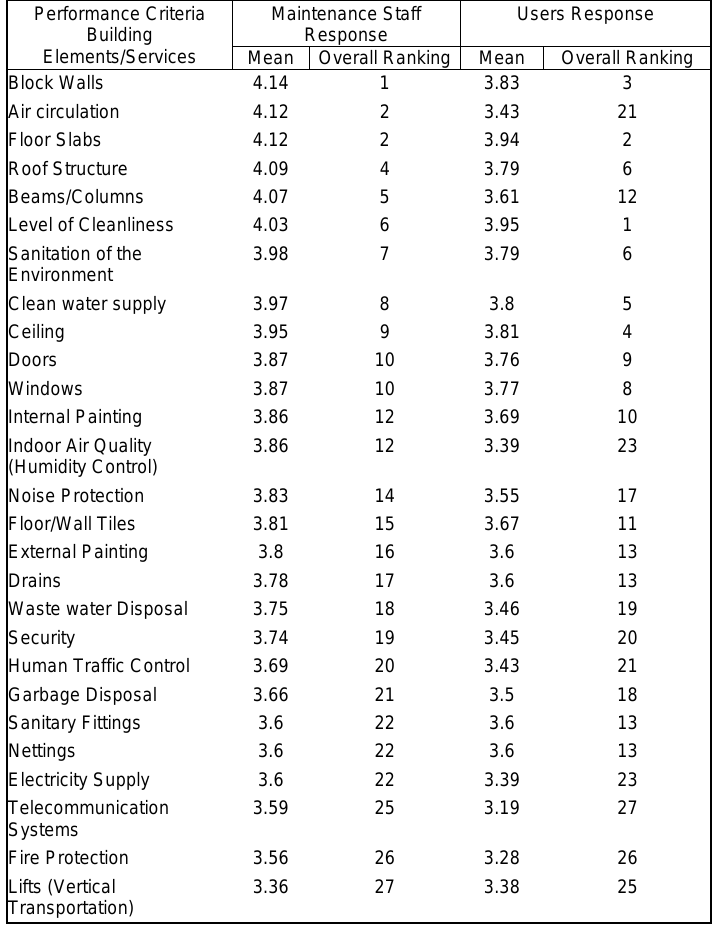
Table 7: Physical conditions of hospital buildings as perceived